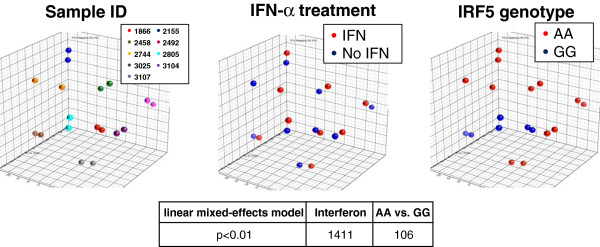
(Top panel) Principal Component Analysis (PCA) based on the gene expression profile of 9 out of 15 melanoma cell lines. The 3D displays of the PCA are color coded by sample ID, IFNα treatment, and IRF5 genotype, respectively. (Bottom panel) Gene expression analysis of cell lines using linear mixed-effects model shows 106 genes were found significant (p < 0.01) for testing the genotype effect and 1411 genes were found significant (p < 0.01) for testing the interferon effect.